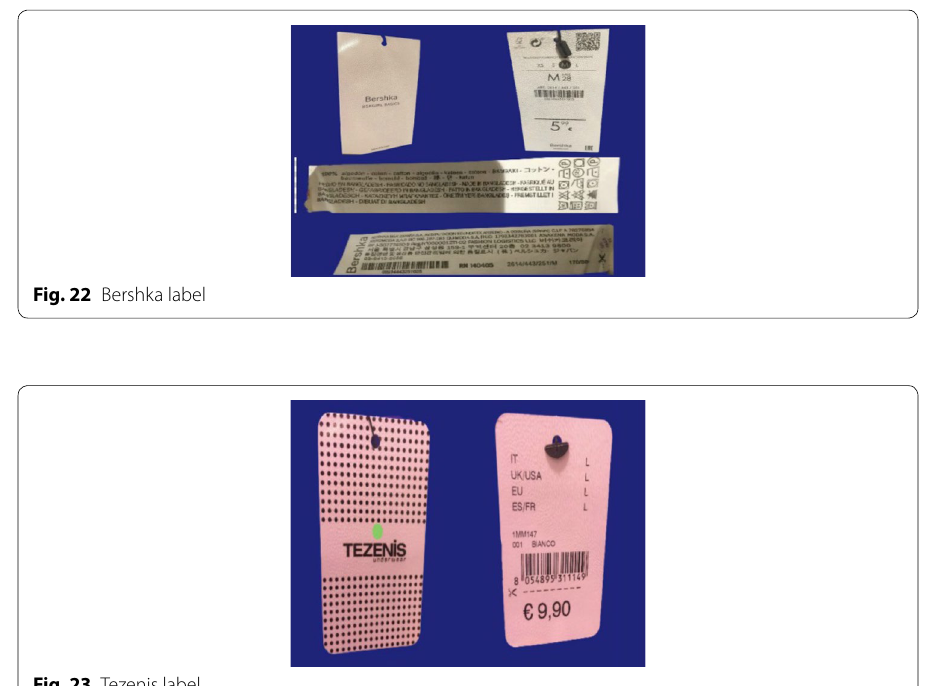
Fig. 23 Tezenis label